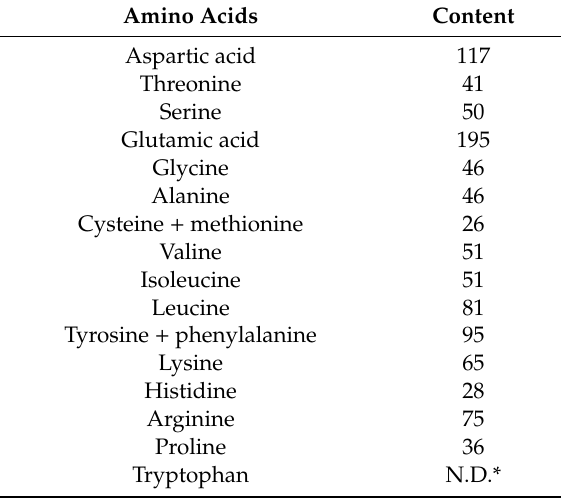
Table 4. Amino acid composition (mg / g of protein) of unmodified okara protein isolate. Amino Acids